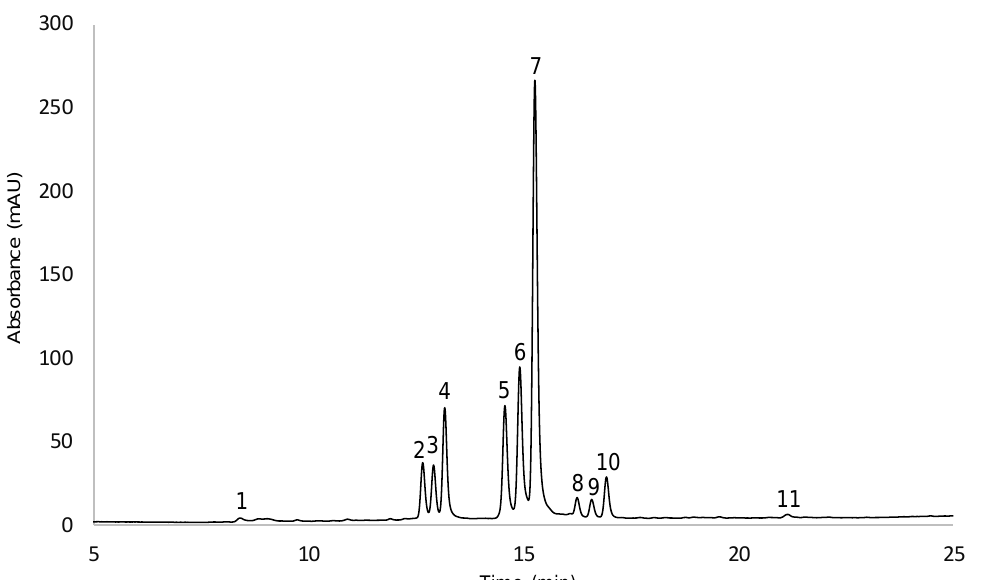
Figure 2. Chromatograms recorded at 420 nm (method B) corresponding to the extraction of a turmeric sample ( Curcuma longa , Erode var.) with methanol. Extraction conditions: A total of 5 mg of sample; 10 mL MeOH; 40 min extraction time with UAE. Separation conditions: X Terra column; elution gradient 40% to 90% ACN in 20 min. Peak assignment: 5 = bisdemethoxycurcumin; 6 = demethoxycurcumin; 7 = curcumin; 1 to 4 and 8 to 11 were other (unknown) curcuminoids.